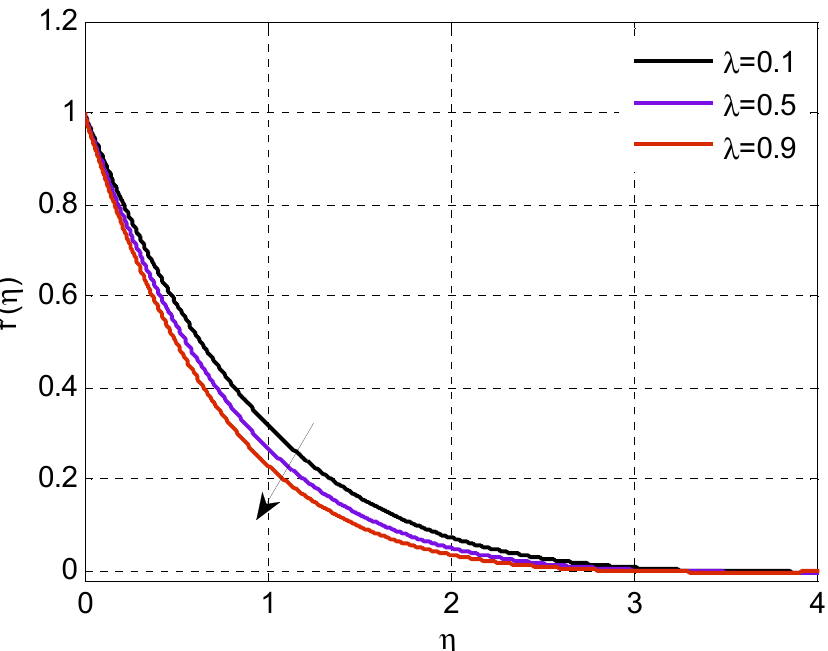
Figure 5. Effect of porosity parameter on velocity profile using G = 1, K b = 0.9, F r = 0.1, and N = 3040.